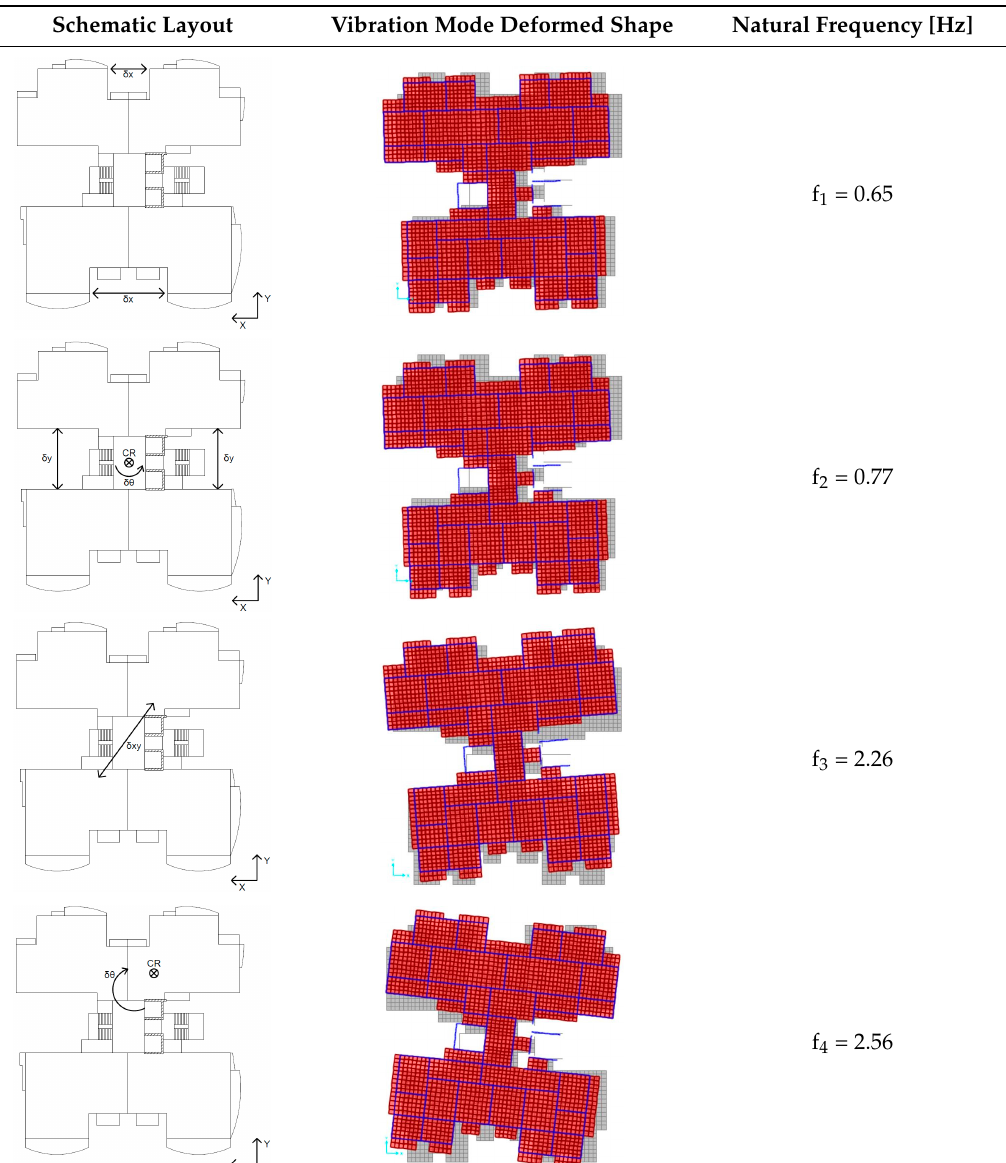
Figure 12. Schematic layout of the infill masonry wall level of damages assumed.